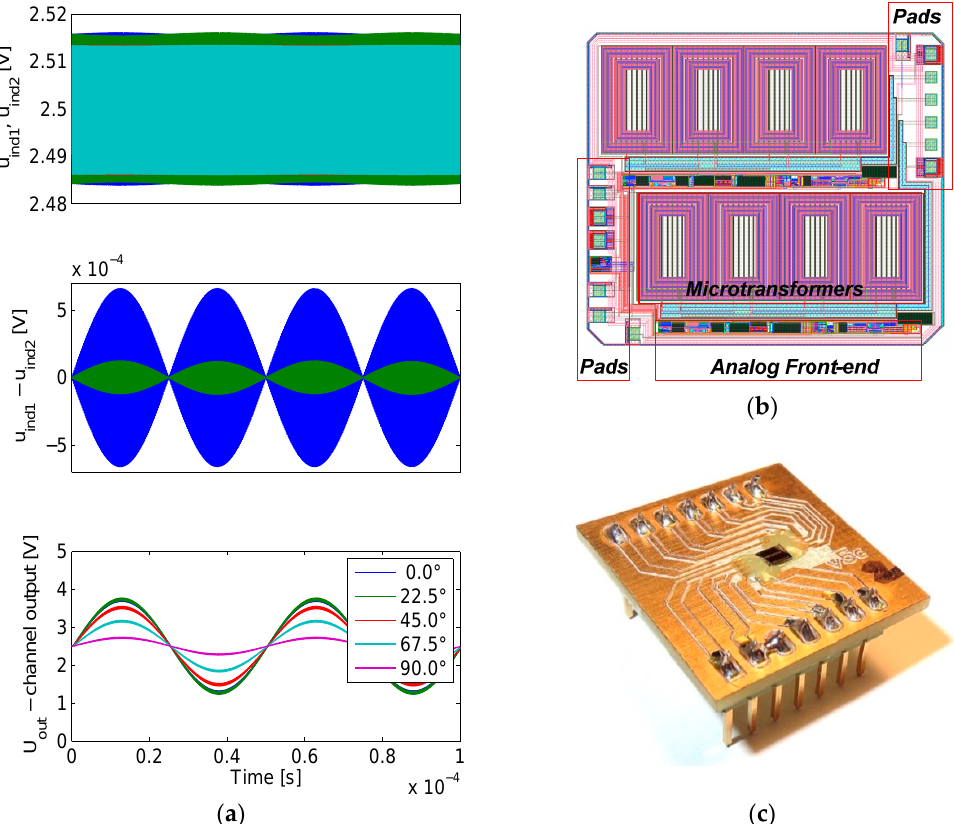
Figure 11. ( a ) Results of Cadence simulations of the measurement channel at 4 MHz operation frequency. In the bottom figure, the mixing signal phase ϕ mix is swept between 0°–90°; ( b ) The layout of the integrated circuit, comprising two identical quadrature channels; ( c ) The fabricated ASIC prototype, mounted on a test PCB.